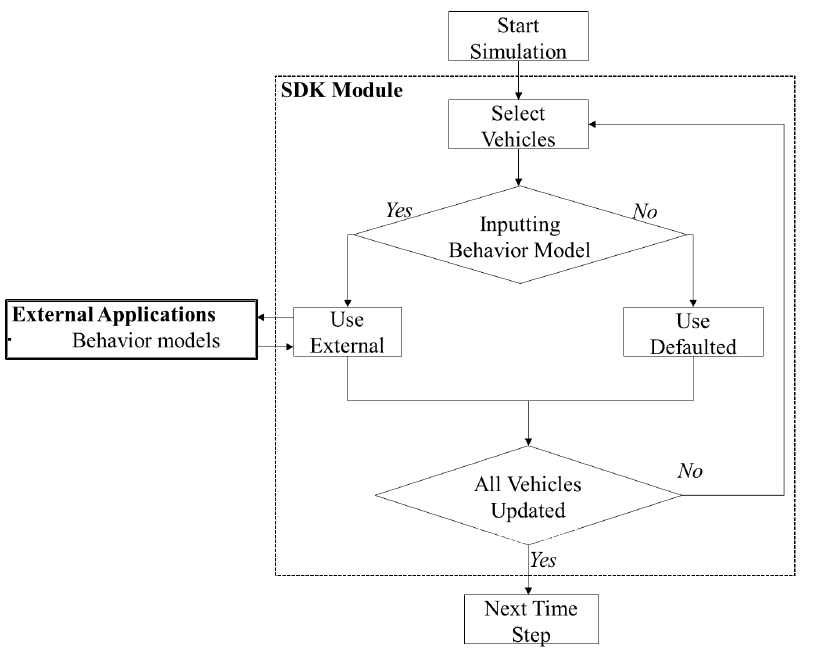
Fig 4. SDK module application